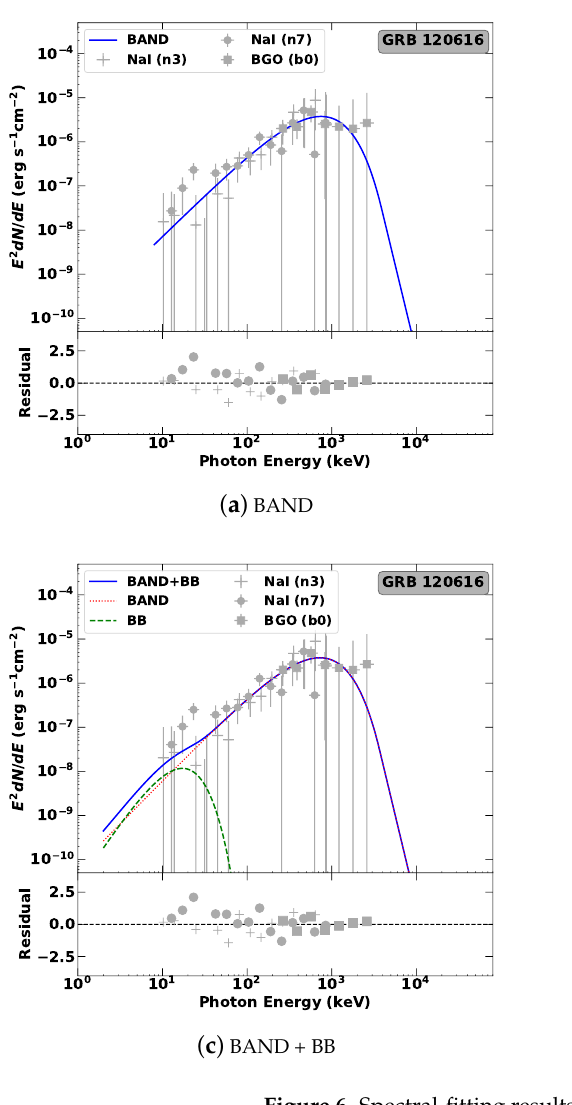
Figure 6. Spectral-fitting results for one GRB in class (iii) that with R > 0.1 in one of the BAND + BB model and the CPL + BB model, such as GRB